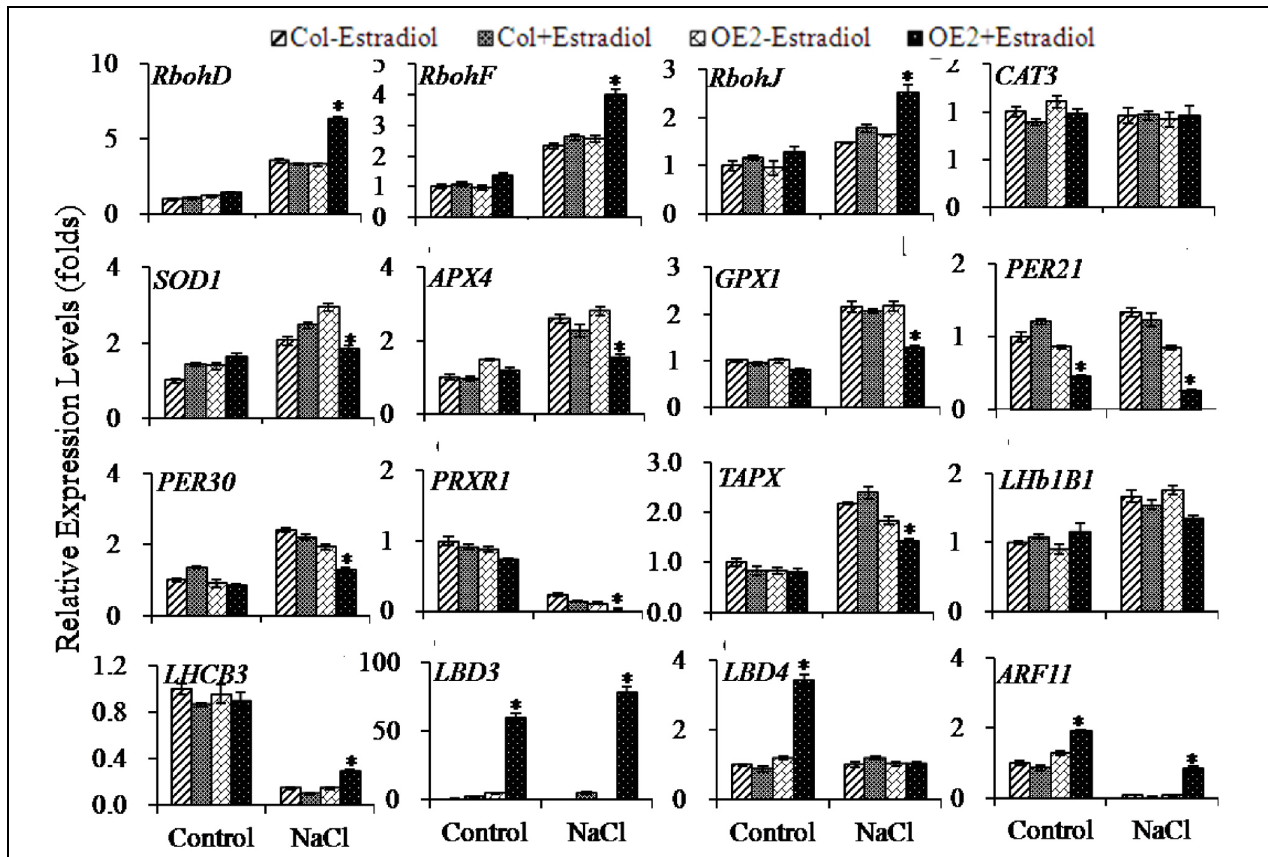
FIGURE 7 | Quantitative analysis on the expression levels of ROS-related and photosynthesis-related genes. 10-day-old plants grown on MS plates were pretreated with DMSO or 17- β -estradiol (10 μ M) for 24 h, and then subjected to treatments (NaCl, 100 mM; with or without estadiol) in liquid MS medium for 3 h. The seedlings were then collected for total RNA extraction and qRT-PCR analysis. Gene expression levels were normalized to their expression levels in Col plants, which were taken as 1. The data are means ± SE of three independent repeats. Asterisk symbols ( ∗ ) indicate p < 0.05 (Student t-